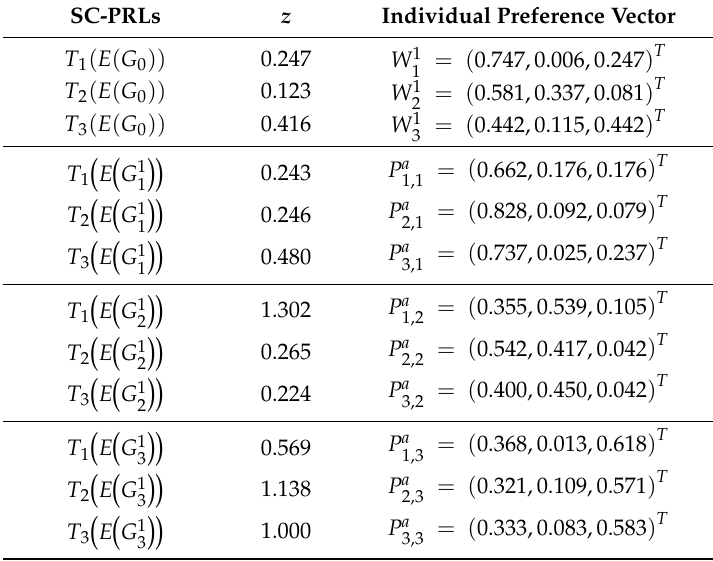
Table 3. Results of decision makers’ individual preference